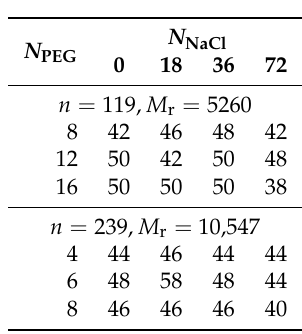
Table 5. Production times (ps) at which the total mass transfer through the plane at z = 20 nm exceeded 2000 Da under 1.5